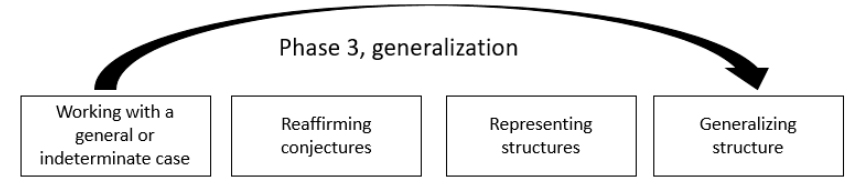
Figure 12. Generalization phase.